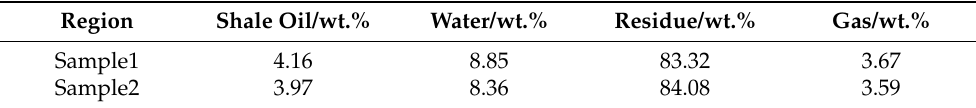
Table 3. Element analysis of Fuyu oil shale. Table 1. Proximate analysis of Fuyu oil shale. Region